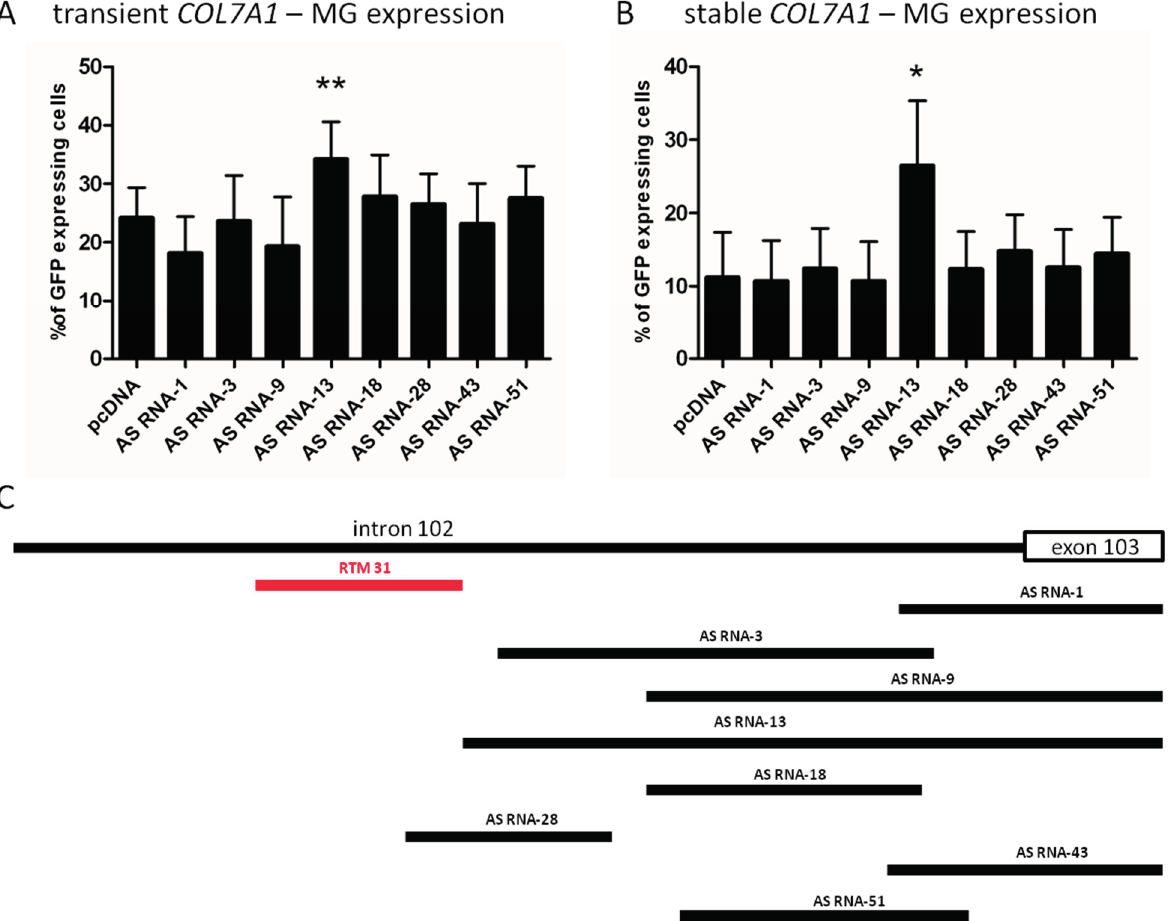
Figure 2. Comparison of AS RNA-mediated influence on trans -splicing efficiency. ( A ) Triple transfections of COL7A1 -MG, RTM_31 and the most promising AS RNA (AS RNA-13) increased the amount of GFP expressing cells upon accurate trans -splicing from 24% to 34%. Mean + SD of five different experiments is shown. An unpaired T-test (two-tailed) was performed with GraphPad Prism software (GraphPad Software, San Diego, CA, USA) to prove the statistical significance between AS RNA-13 and the control pcDNA ( ** p value = 0.0073); ( B ) Co-transfection of RTM_31 and individual AS RNAs of the library into a COL7A1 -MG expressing target cell line leads to a variable trans -splicing rate. AS RNA-13 showed the most promising effect, capable of increasing the trans -splicing efficiency of the RTM 2–3-fold on the protein level (measured by flow cytometry). AS RNA-13 was compared to the control (pcDNA). The mean + SD of 4 different experiments is shown. Unpaired, two-tailed t -test ( * p value = 0.0298) confirmed statistical the significant increase in AS RNA-13 compared to the control pcDNA; and ( C ) Binding position of RTM_31 (red) and individual AS RNAs within the COL7A1 target